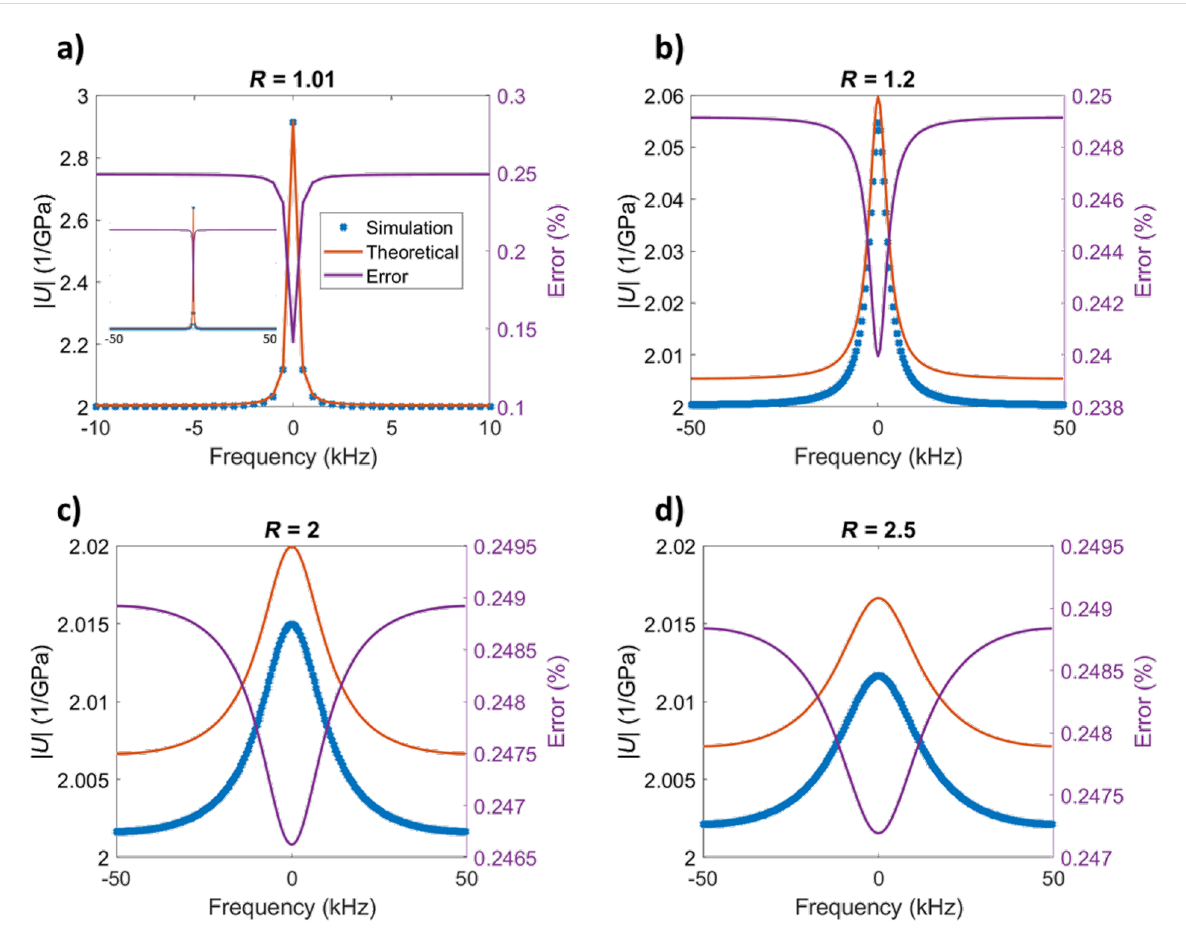
Figure 7: Material retardance amplitude plotted around the origin (i.e., for constant radius and varying frequency – recall that z = e α e i ω ), for circles with different radii on the z -plane. The radii of the circles are respectively 1.01, 1.2, 2, and 2.5. As the figures show, the retardance calculated from the simulations and the theoretical values match closely with an error below 0.25%. Notice that the smallest error is observed on the real axis in all cases, which corresponds to zero frequency.